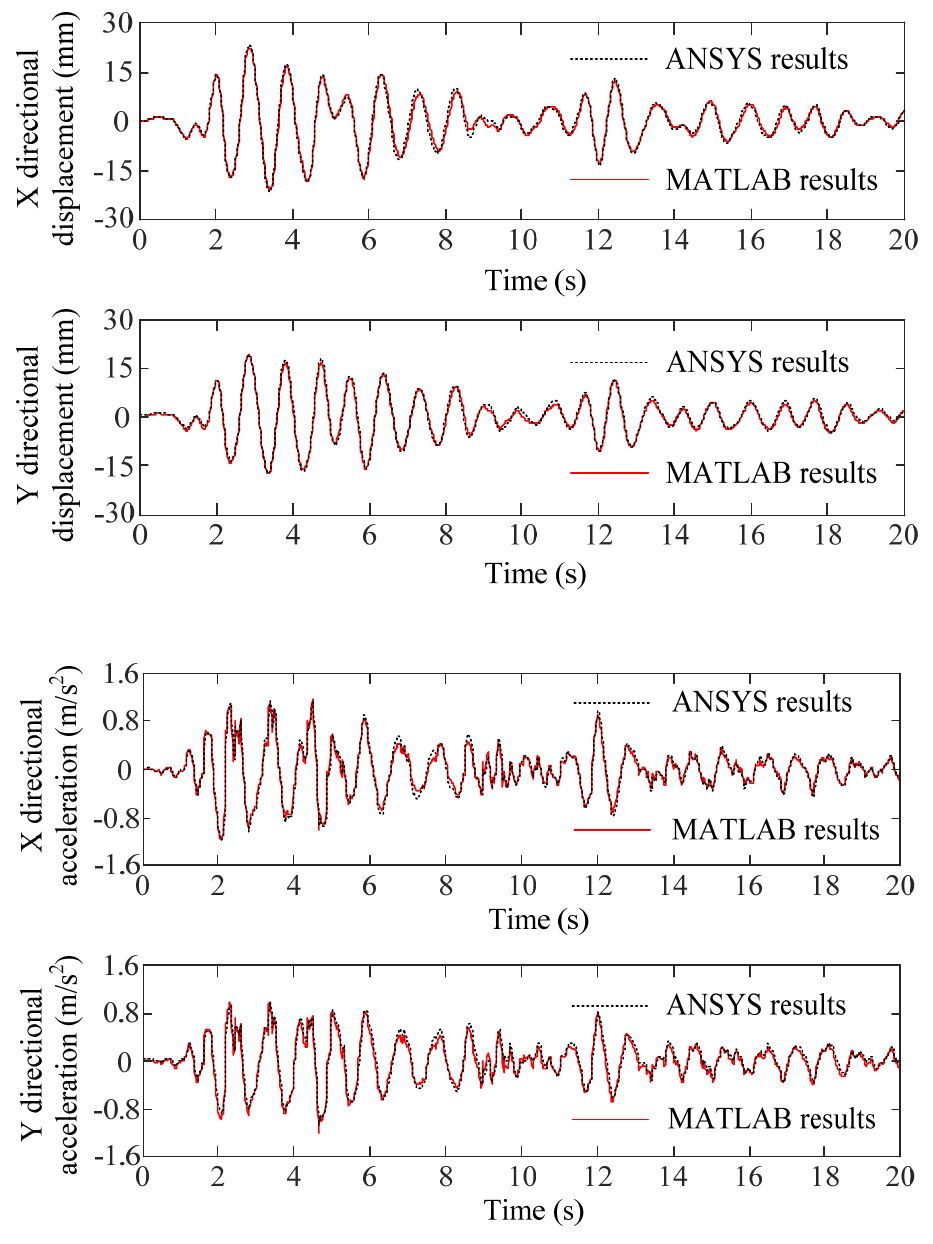
Figure 8. Contrasts of time history response of Node 141 between the self-compiled program and the ANSYS model.